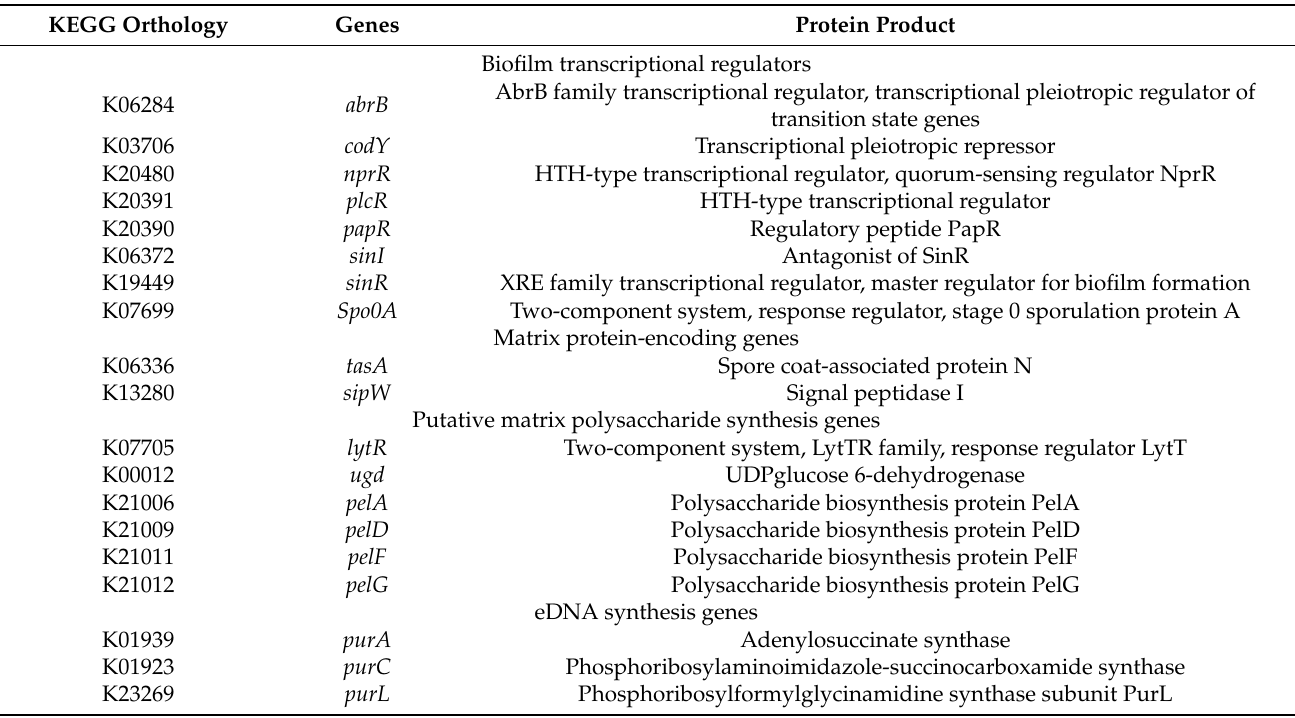
Table 5. Identification of genes in Bacillus sp. B87 relevant to biofilm formation annotated using the KAAS database.